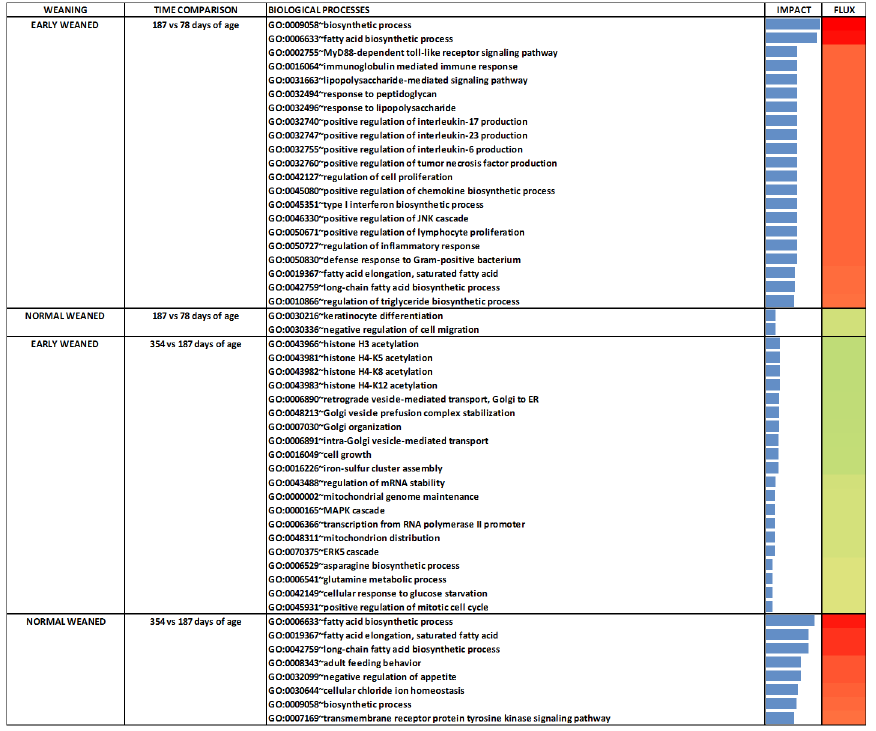
Fig 6. Significant biological processes in the comparison of differentially expressed genes between early wean (EW) and normal wean (NW) steers at 78 and 187 days of age and 187 and 354 days of age. Flux represents the direction of each category and the corresponding subcategory (green color = inhibition, yellow color = stable, red color = activation with different color intensities according with the level of up- regulation or down-regulation). Blue bars denote the impact of each biological